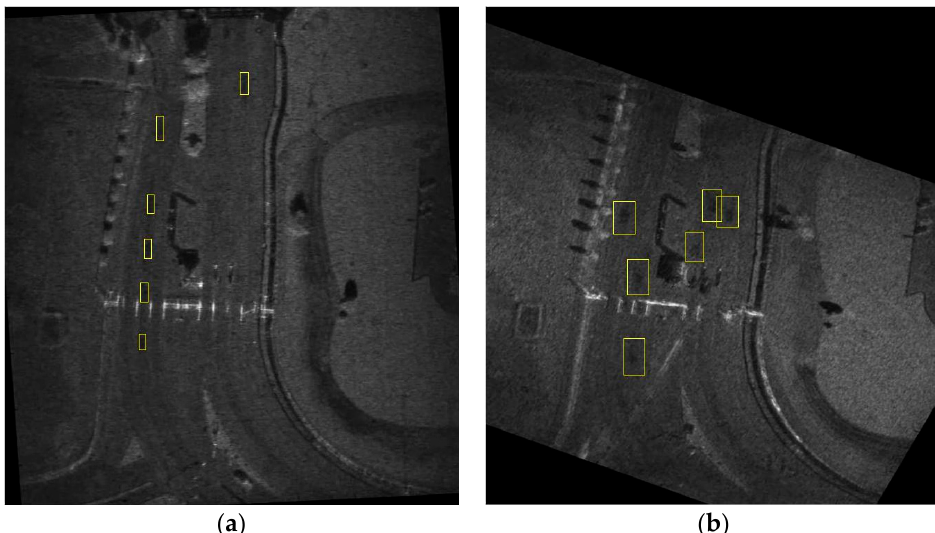
Figure 5. Results of detection of the shadow of a moving target on the ground in SNL VideoSAR data. The yellow rectangles highlight the shadow of the marked moving car. ( a ) The 23rd frame. ( b ) The 551st frame.